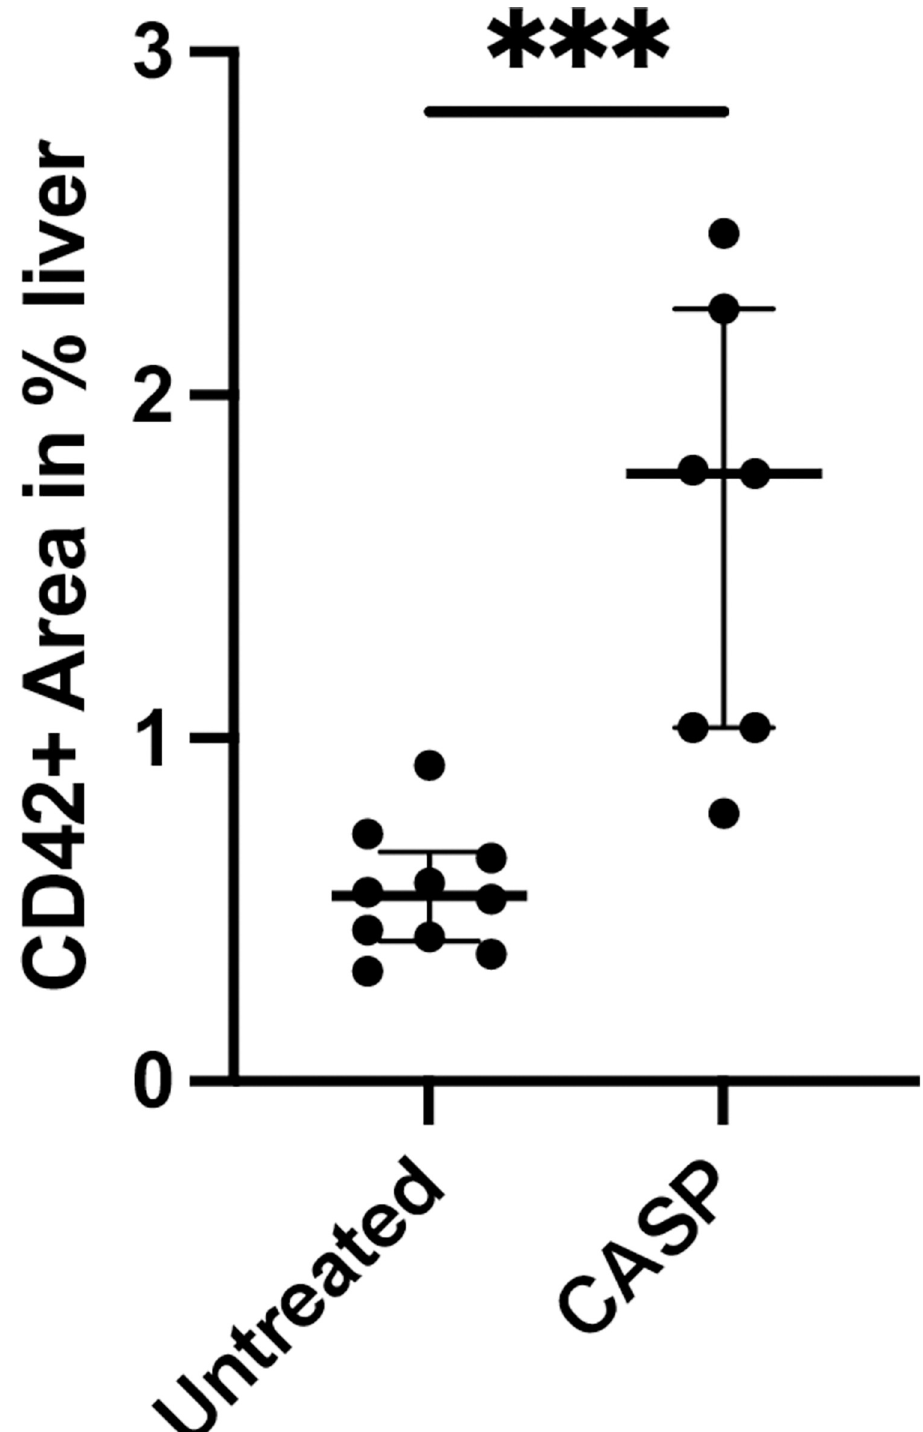
Fig 8. Accumulation of hepatic platelets 20 hours after CASP surgery. Pictured is the percentage area of FITC/Alexa 488-positive areas on the fluorescent section in proportion to the entire section. There was a significant increase (p < 0.001 ��� ) in the percentage of the FITC/Alexa 488-positive area, i.e., an increased accumulation of hepatic platelets in CASP-operated animals of 1.77% (1.69% IQR) of the area (n = 7) compared to untreated animals with 0.54% (0.6% IQR) of the FITC-positive area (n = 10). The bold black line depicts the median.